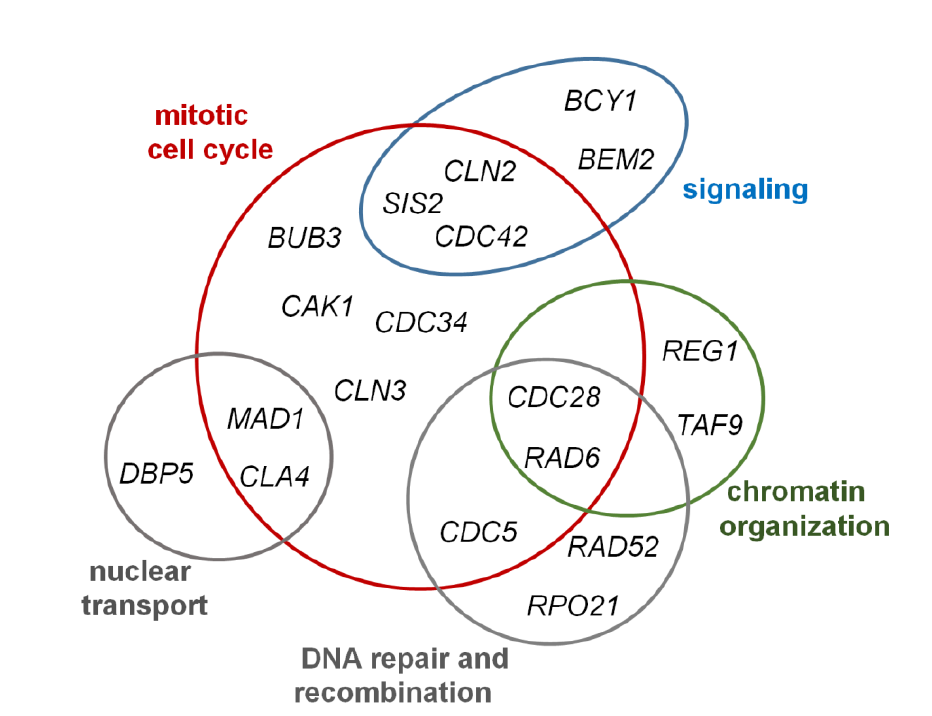
Microbial Cell | MAY 2019 | Vol. 6 No. 5